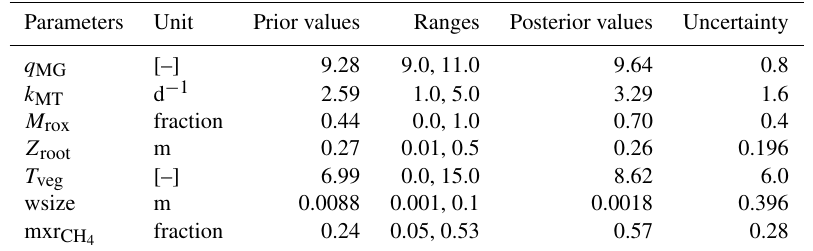
Table 6. Multi-site prior and optimized values of methane scheme parameters. Parameter prior values are the average value of the parameters optimized at each site. Parameter descriptions and references are in Table 3.